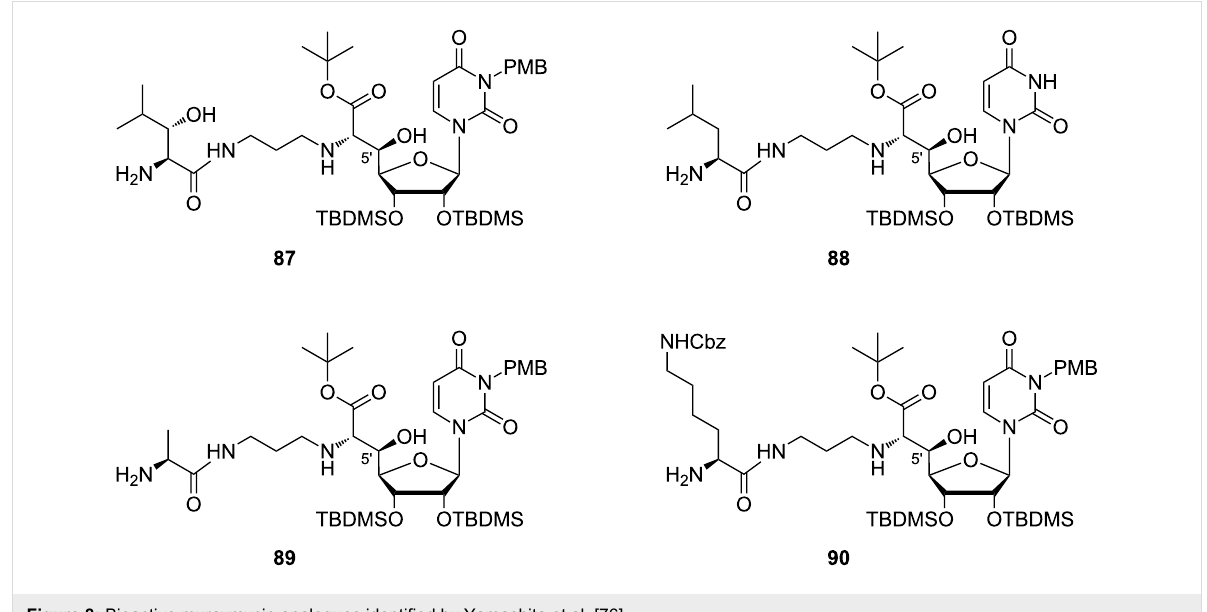
Figure 8: Bioactive muraymycin analogues identified by Yamashita et al. [76]